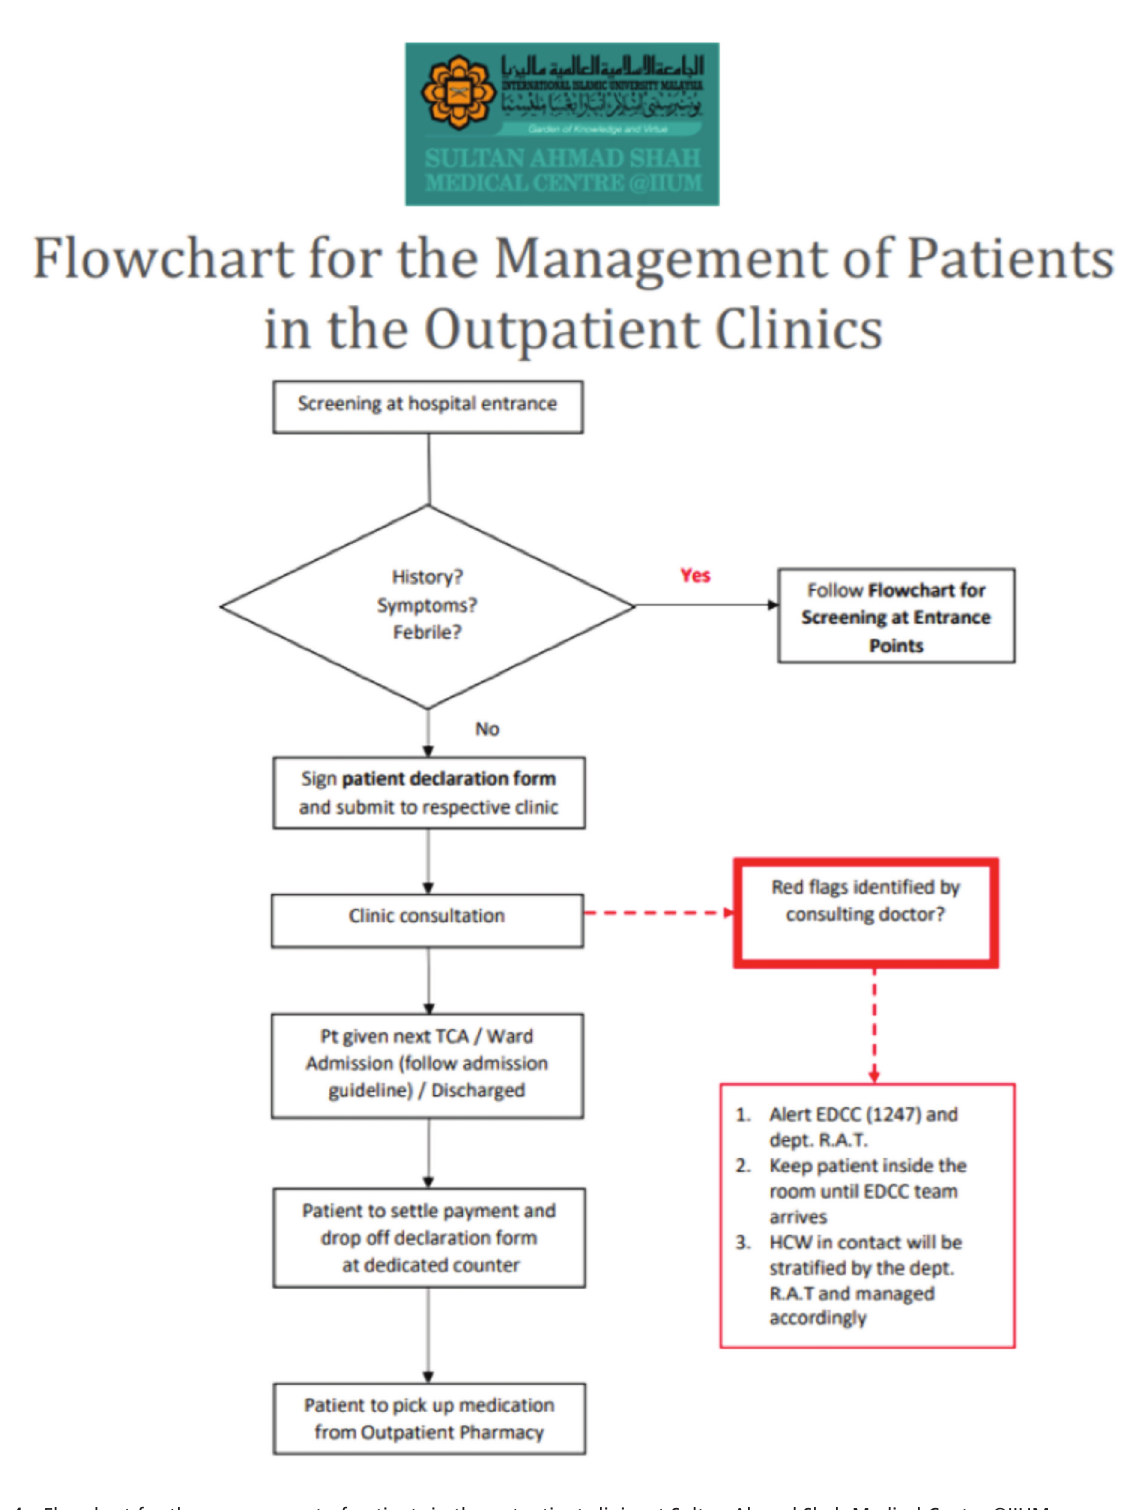
Flowchart for the management of patients in the outpatient clinics at Sultan Ahmad Shah Medical Centre Fig. 4: